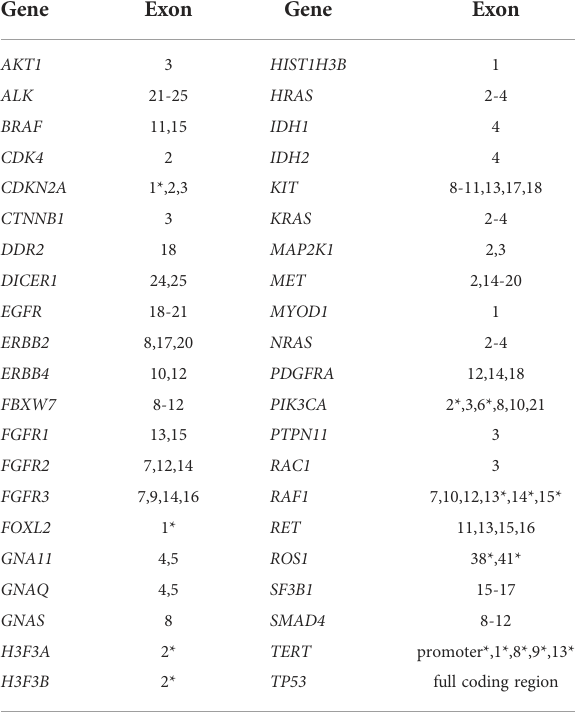
TABLE 4 List of the genes and their exons targeted by